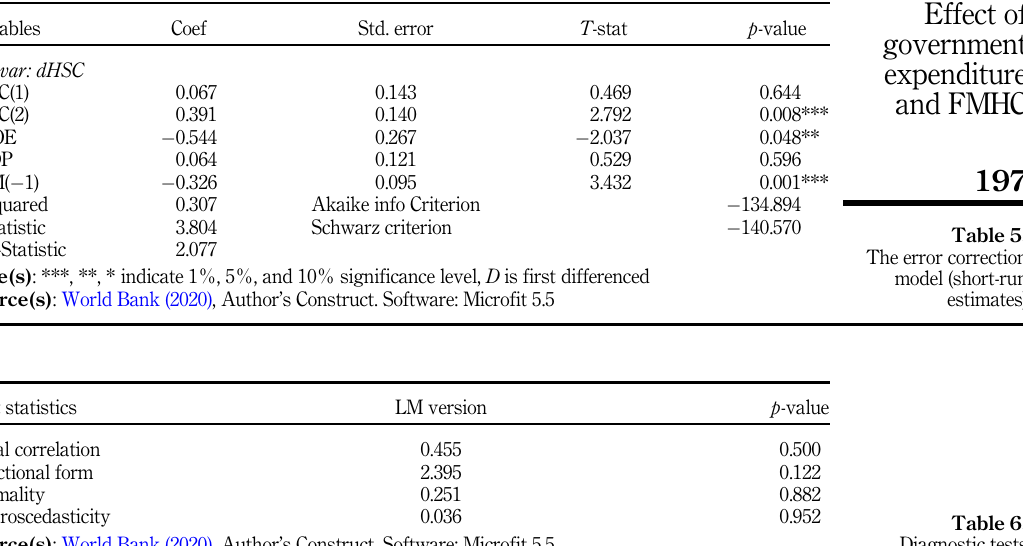
Table 6. Diagnostic tests